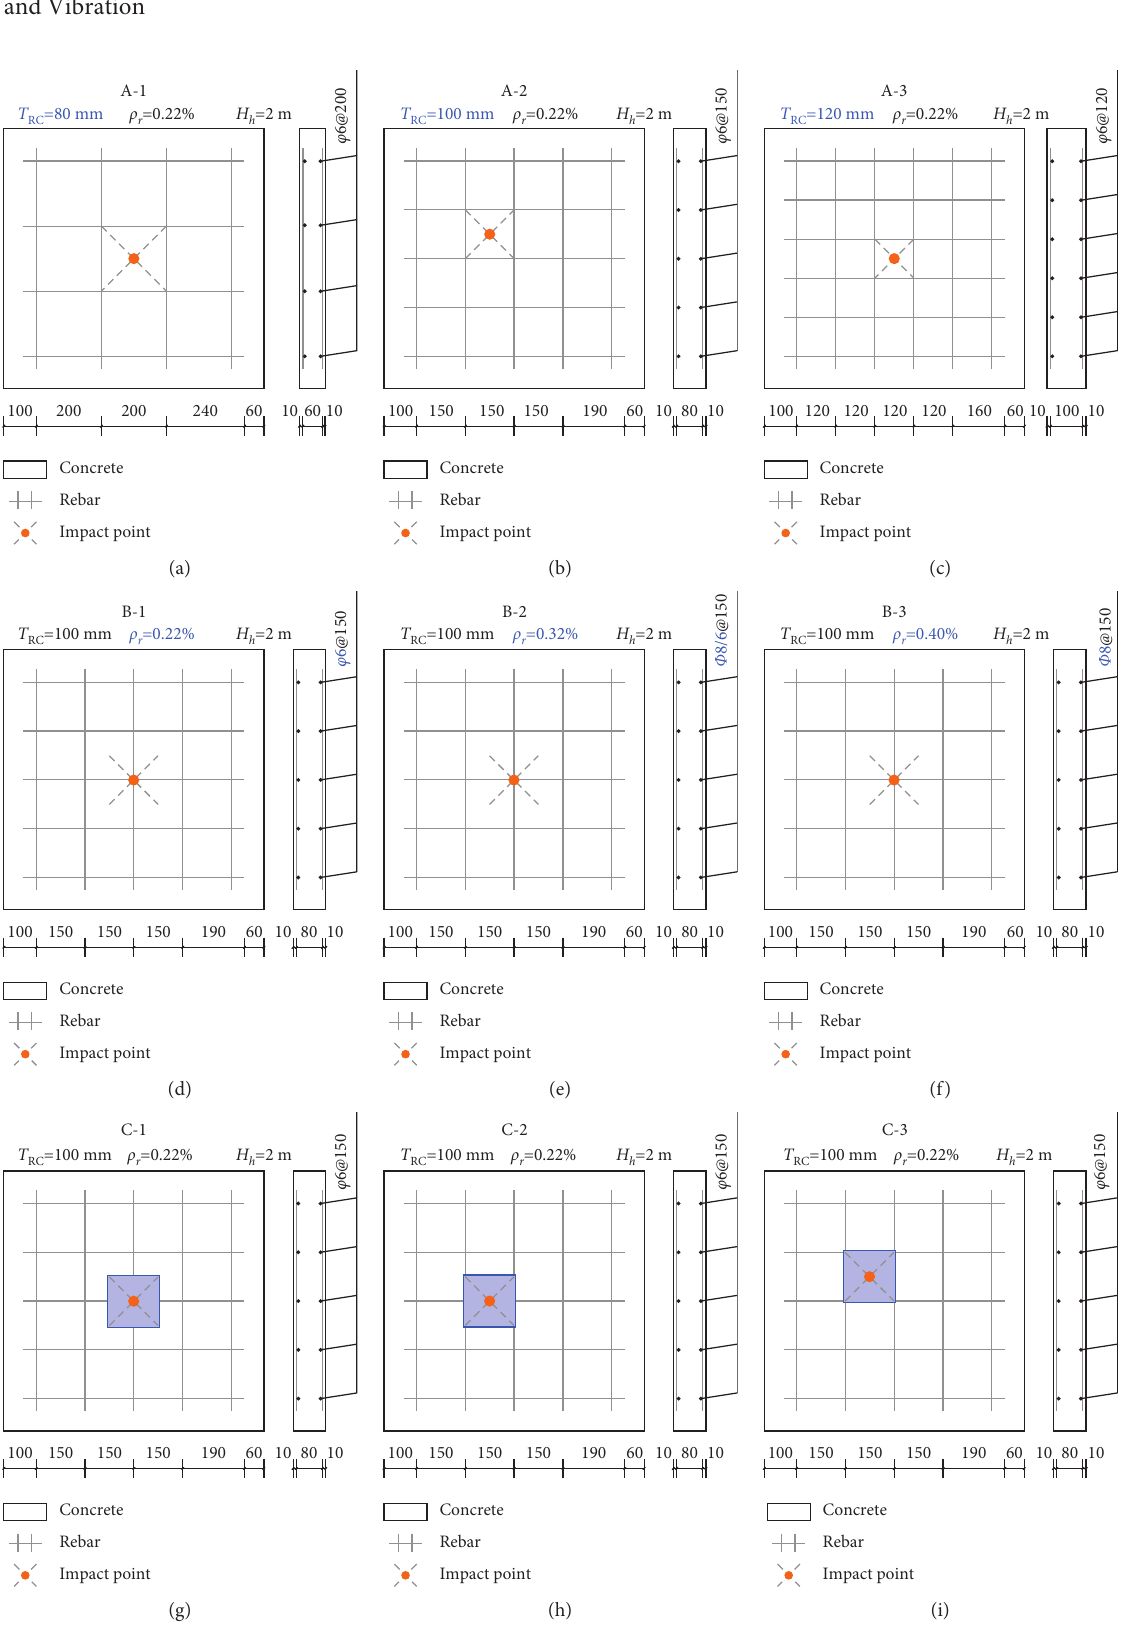
Figure 1: Design of specimens. (a) A-1. (b) A-2. (c) A-3. (d) B-1. (e) B-2. (f) B-3. (g) C-1. (h) C-2. (i)